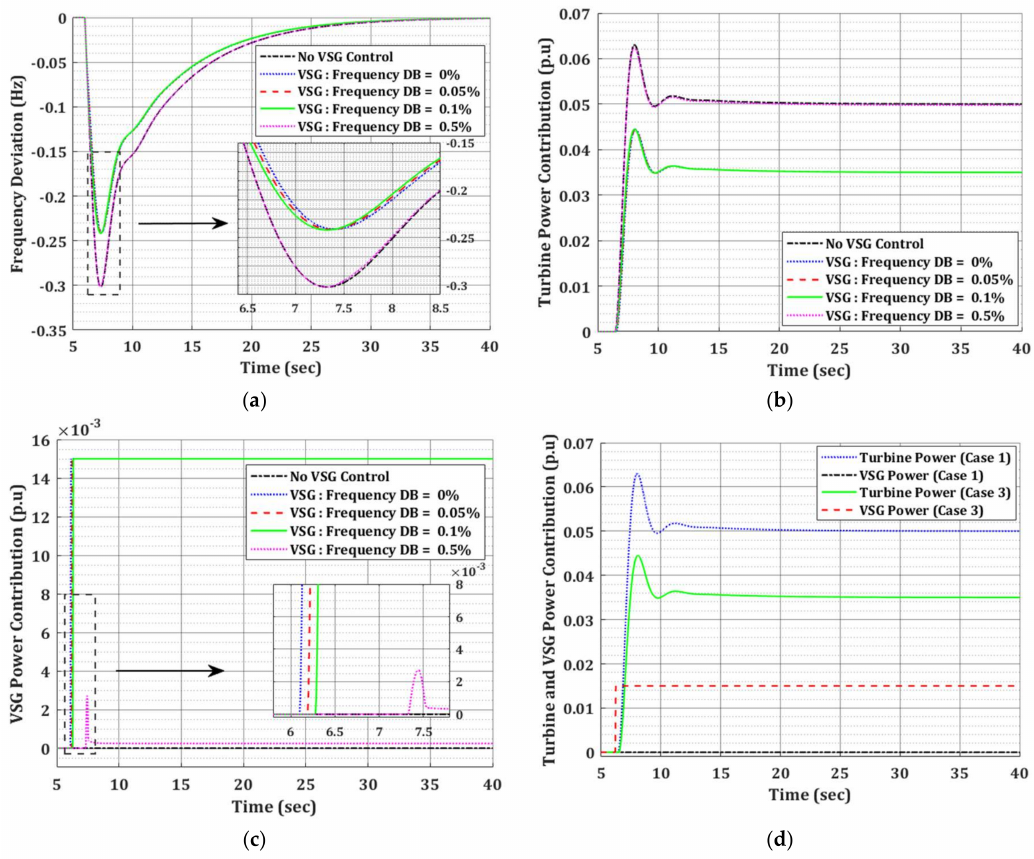
Figure 8. Effect of frequency deadband ( f VSG , DB ) on various system parameters under load disturbance: ( a ) system frequency response; ( b ) change in turbine power (p.u); ( c ) change in VSG power (p.u); and ( d ) change in turbine and VSG power (p.u) for selected